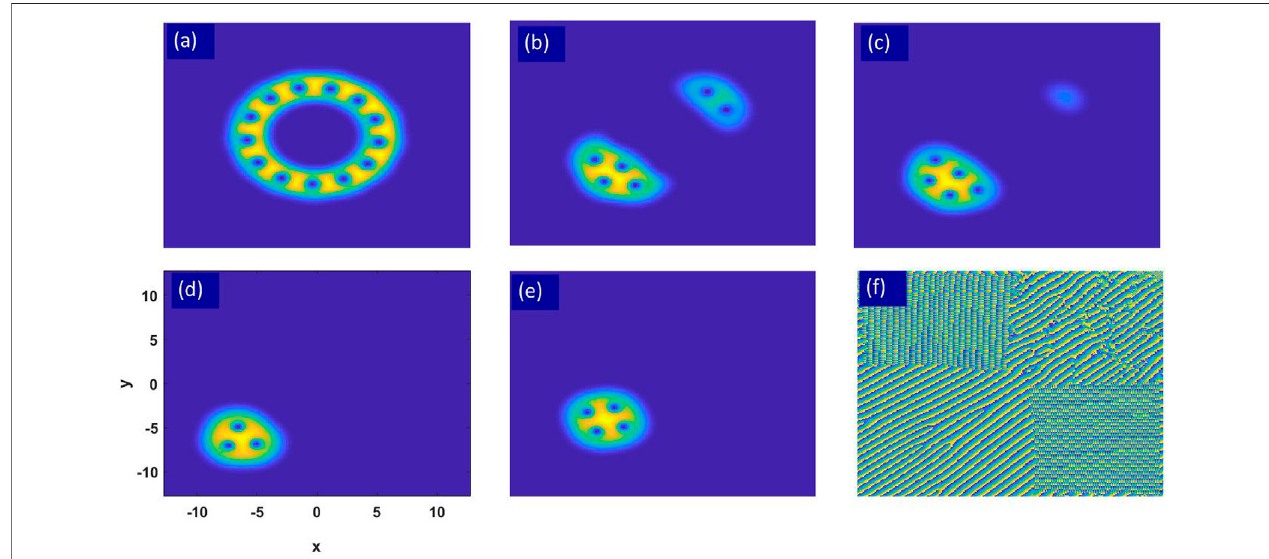
FIGURE 3 | Typical ground-state structures of a rotating BEC as a function of the SU(3) spin – orbit coupling and gradient magnetic fi eld. (A) – (D) Density distributionsofcomponent1for a fi xed gradient magnetic fi eld B (cid:1) 2andfor differentSU(3) spin – orbit coupling: (A) κ (cid:1) 0, (B) κ (cid:1) 0.5, (C) κ (cid:1) 1,and (D) κ (cid:1) 2. (E) Density distributionofthesystemfor κ (cid:1) 2and B (cid:1) 1. (F) Thecorrespondingphasedistributionof (D) .Otherparametersare fi xedas c 0 (cid:1) 100, c 2 (cid:1) 3,and Ω (cid:1) 0.7,andthescaleof each fi gure is [ − 12.8,12.8] in units of l ⊥ (cid:1) [ Z / M ω ⊥ ] 1/2 .